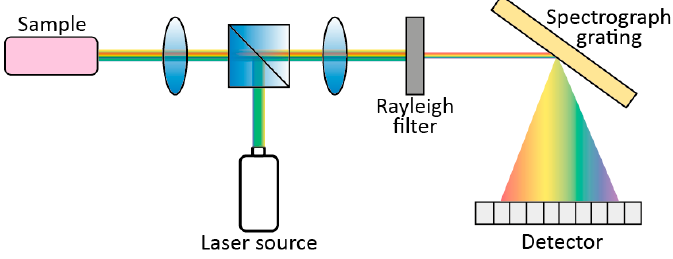
Figure 3. Typical components of a Raman spectrometer.